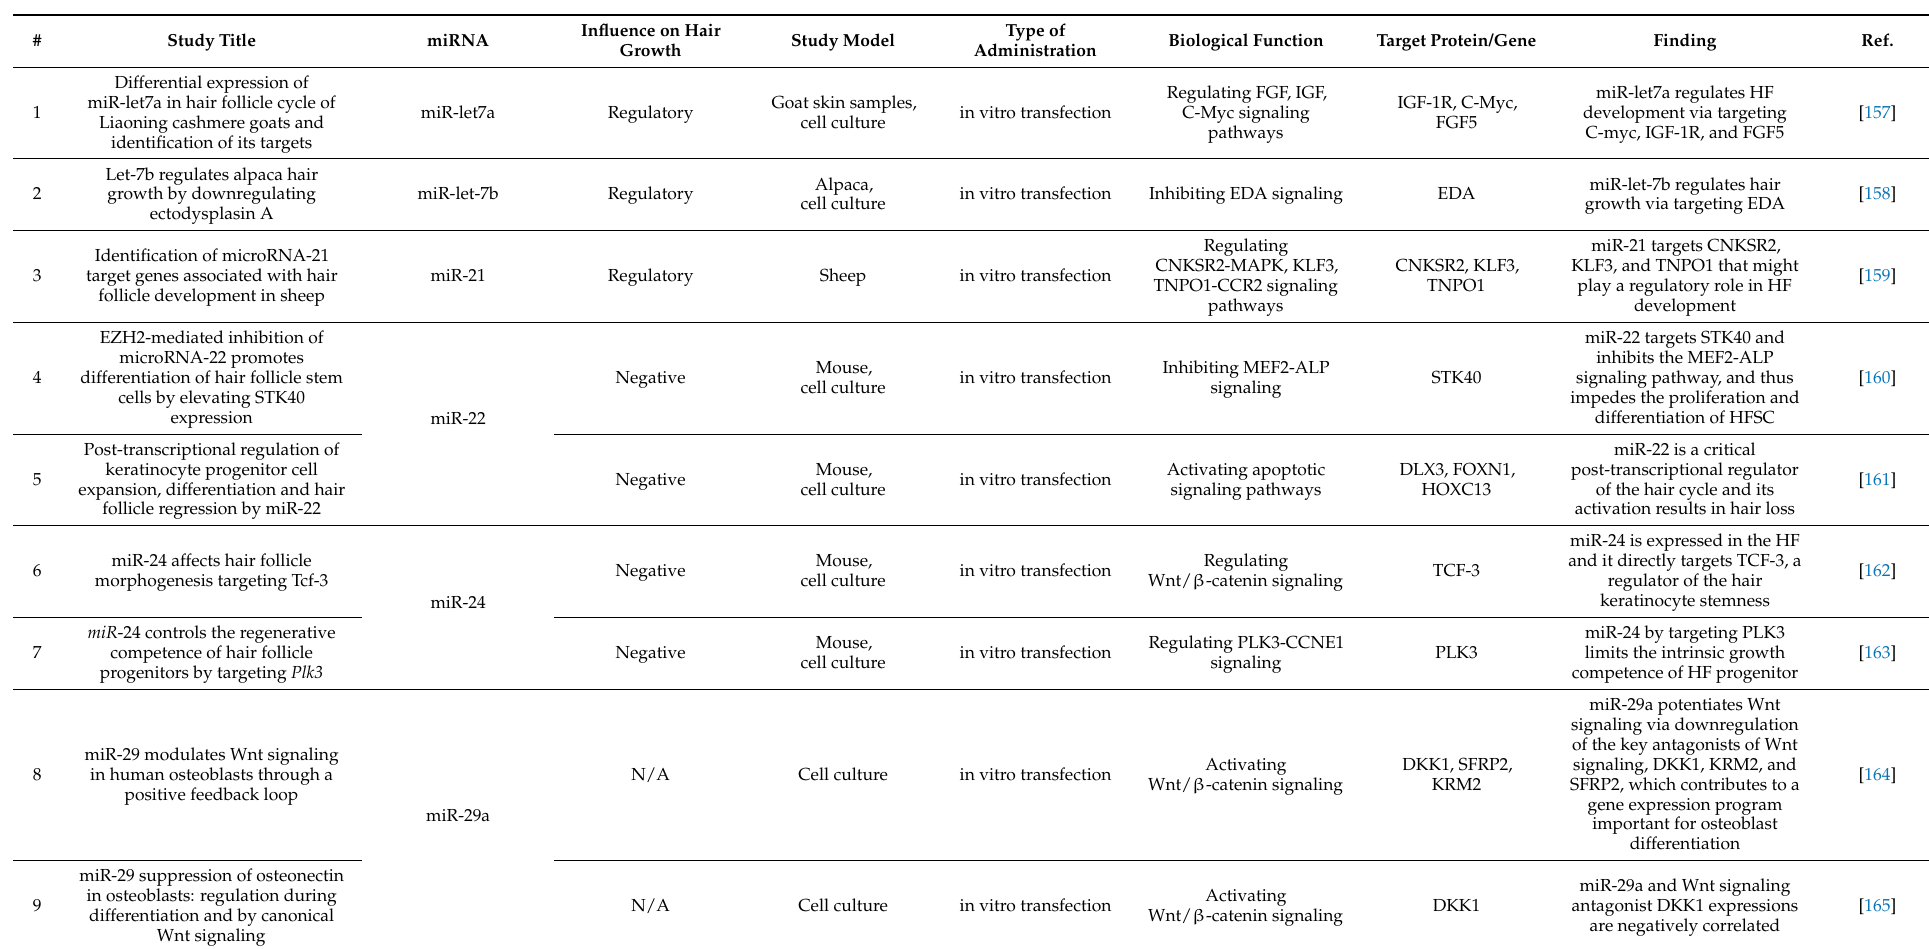
Table 2. Studies focusing on miRNAs that are involved in hair growth and/or related signaling pathways and targeting proteins that are possibly implicated in hair growth